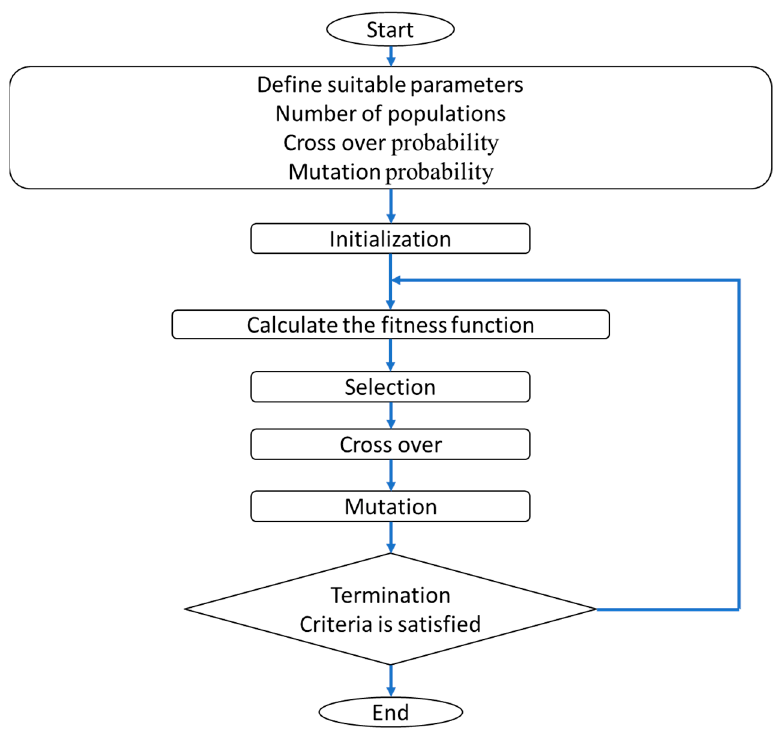
Figure 6. Genetic algorithm flow chart.